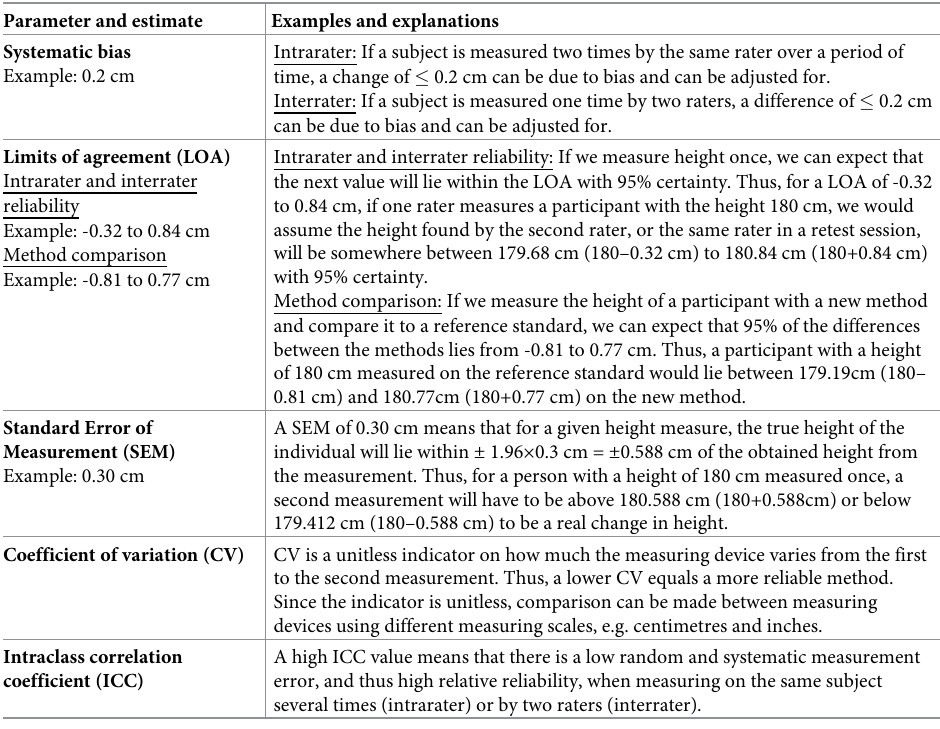
Table 4. How should clinicians interpret our